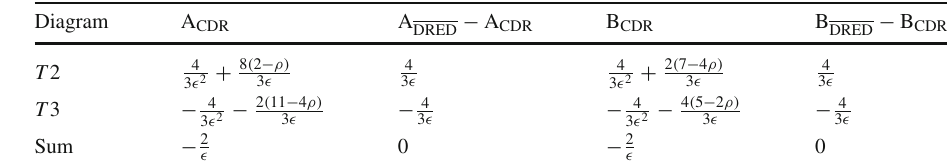
Table 7 Results for spinorial QED using CDR and DRED, where